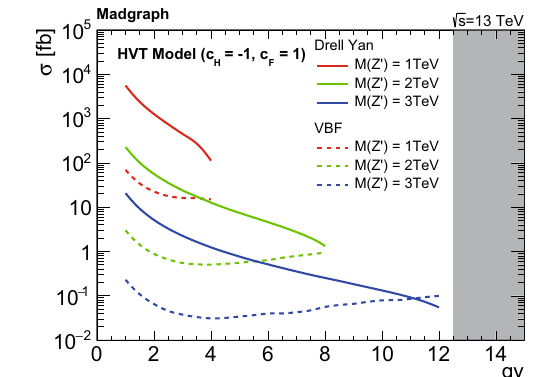
Fig. 6 HeavyresonancecrosssectionsfortheDYandVBFproduction modes, as a function of the g V coupling